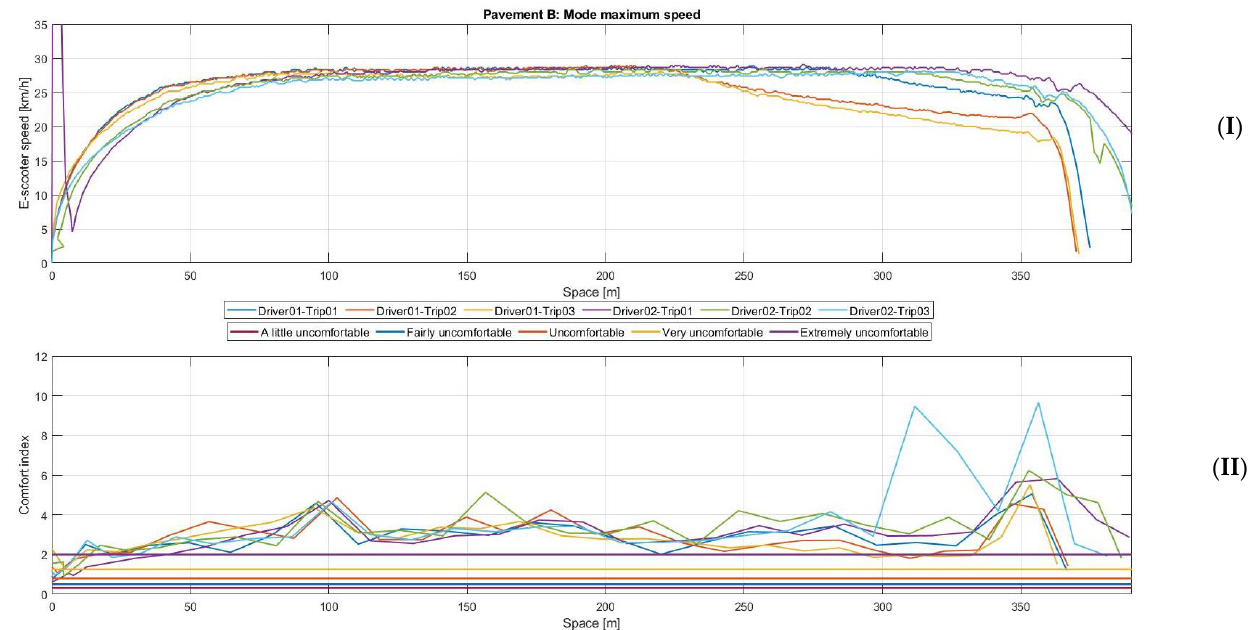
Figure 10. Speed profile ( I ) and comfort index ( II ) for 2 s RMS, pavement B, and mode MAX.